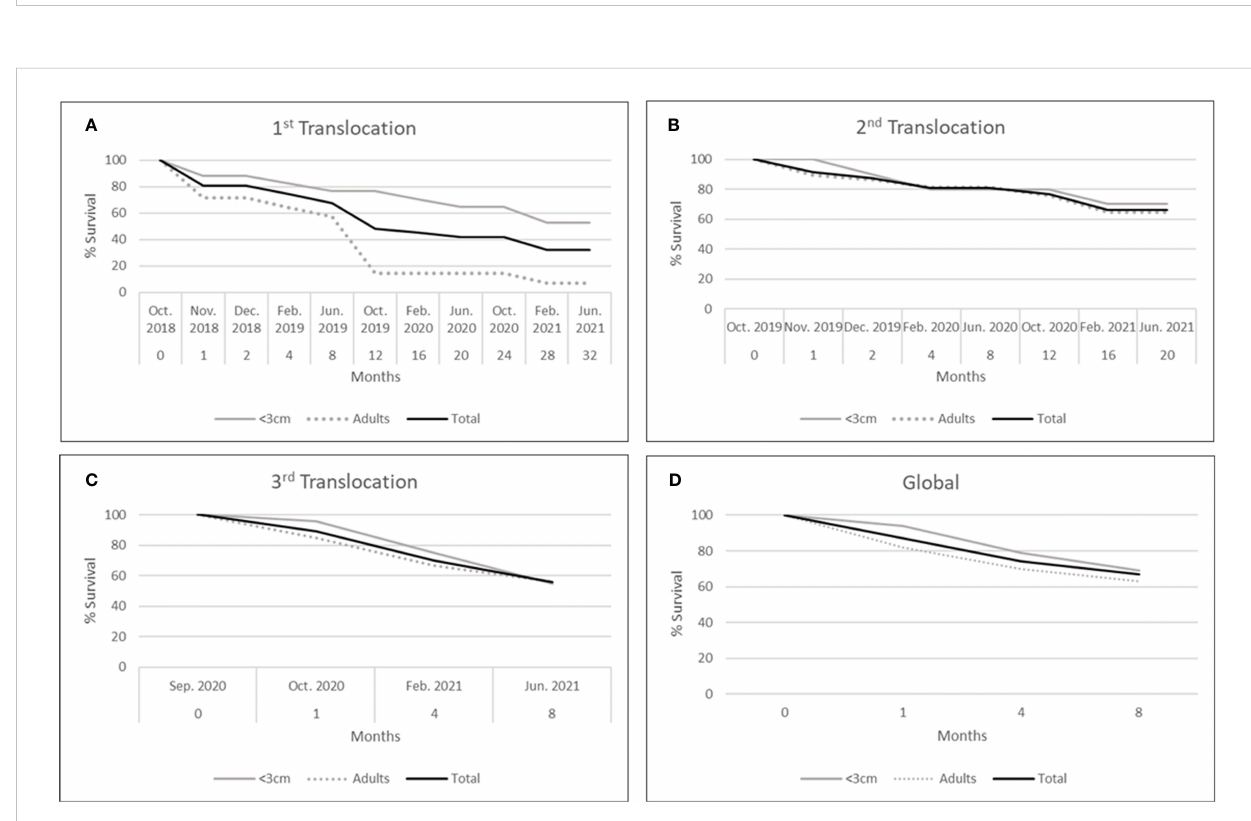
FIGURE 8 Survival percentage for each translocation done and size class (<3 cm: recruits, >3 cm: adults). (A) : fi rst translocation (2018); (B) : second translocation (2019); (C) : third translocation (2020); (D) : mean values of the three